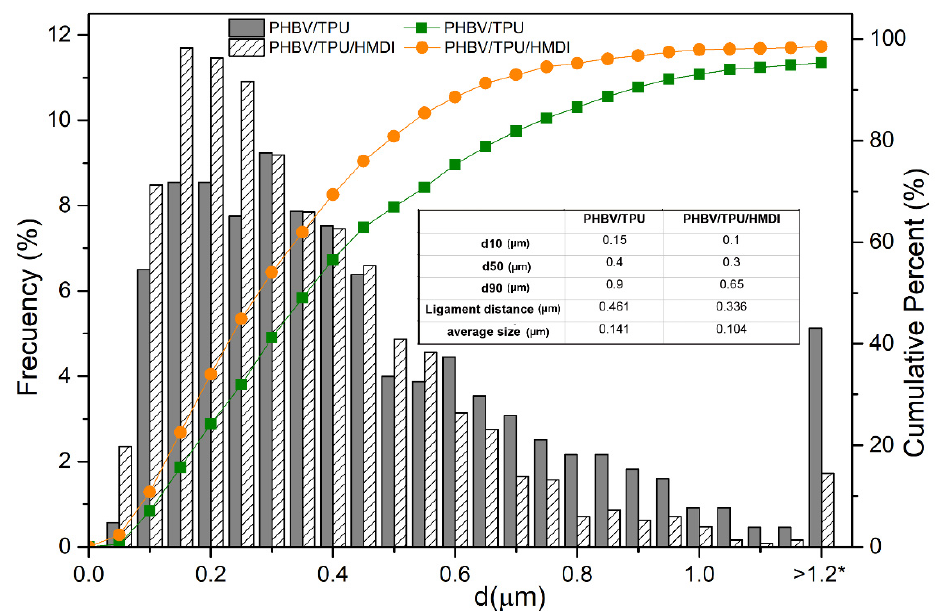
Figure 2. The particle size distributions of the TPU droplets in the blends, where the effect of the addition of HMDI is evidenced. * Frequency of droplets larger than 1.2 µm.